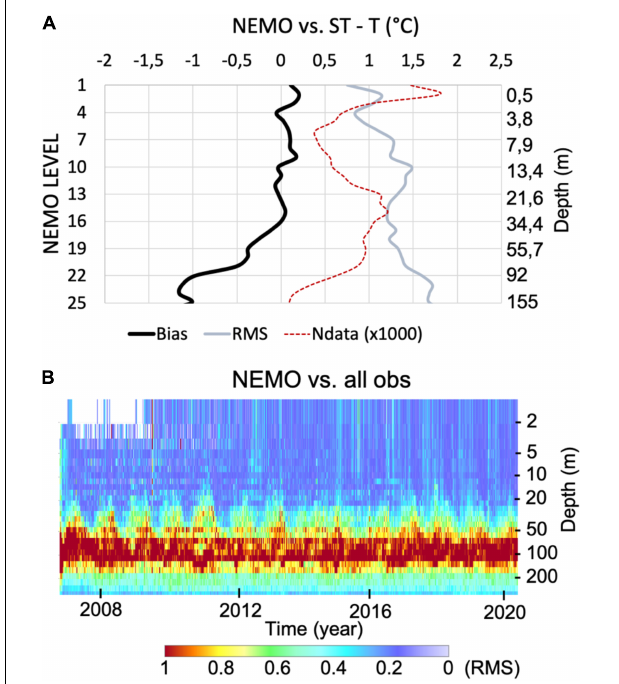
FIGURE 10 | (A) bias (black curve) and RMS (gray curve) errors between Glo12 temperature forecasts and ST-observations as a function of model level (left axis)/depth (right axis) in the W tropical Indian Ocean (20 ◦ S–15 ◦ N; 40 ◦ E–60 ◦ E). The red curve indicates the number of model grid points considered in the analysis at each level ( x-axis × 1,000). (B) Time series of operational RMS error estimates against all available in-situ temperature